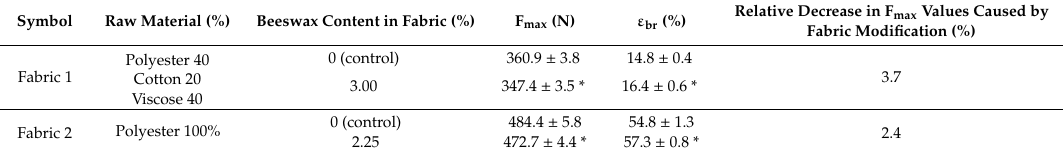
Table 3. Tensile strength (F max ) and elongation at break ( ε br ) of fabrics after modification with beeswax. Symbol Raw Material (%) Beeswax Content in Fabric (%) ε br (%) Relative Decrease in F max Values Caused by Fabric Modification